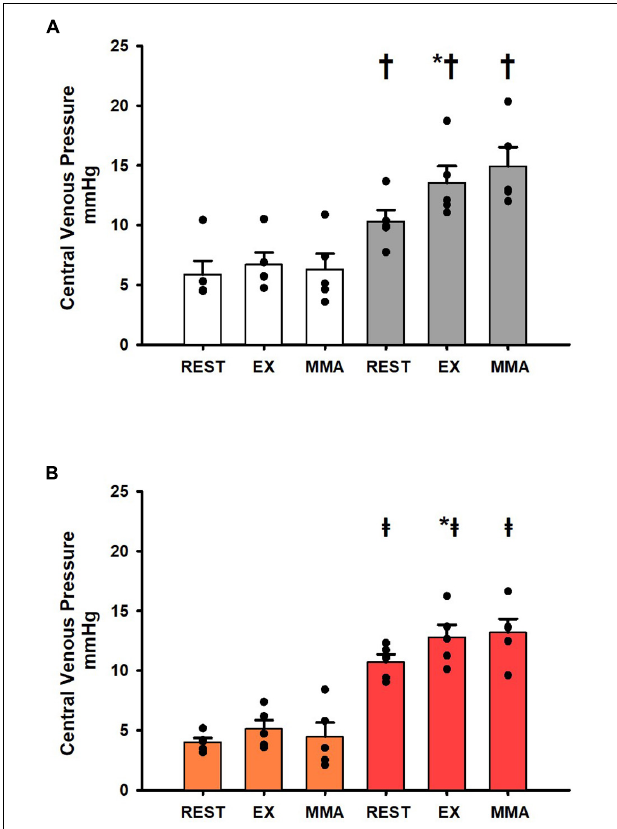
FIGURE 5 | (A) Average 1-min steady state values of central venous pressure from the Control group at rest, exercise (EX), and exercise with muscle metaboreflex activation (MMA) before (white) and after induction of heart failure (gray). Data are reported as means with standard error. Observed data points are overlain on corresponding bar graphs. Statistical significance vs. previous workload is depicted as * and vs. previous condition as † where P < 0.05. ( N = 5). (B) Average 1-min steady state values of central venous pressure from the SAD group at rest, exercise (EX), and exercise with muscle metaboreflex activation (MMA) after SAD (orange) and after induction of heart failure post SAD (red). Data are reported as means with standard error. Observed data points are overlain on corresponding bar graphs. Statistical significance vs. previous workload depicted as * where P < 0.05. Comparisons of the condition of SAD vs. Heart failure SAD depicted as ‡ where P < 0.05. ( N = 5).